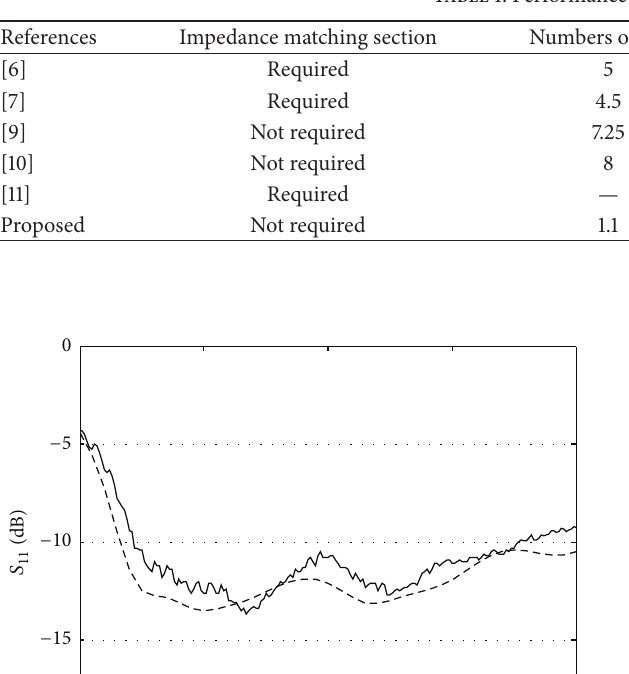
Table 1: Performance of helical antennas.